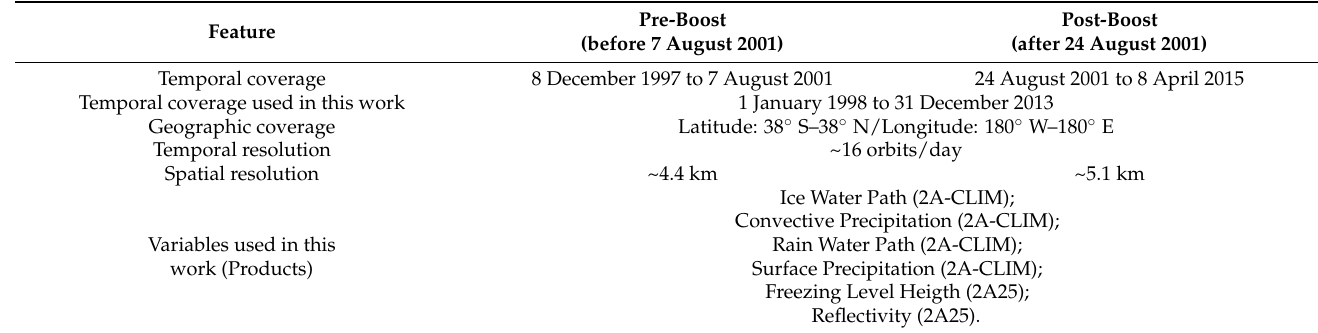
Table 1. Attributes of 2A-CLIM and 2A25